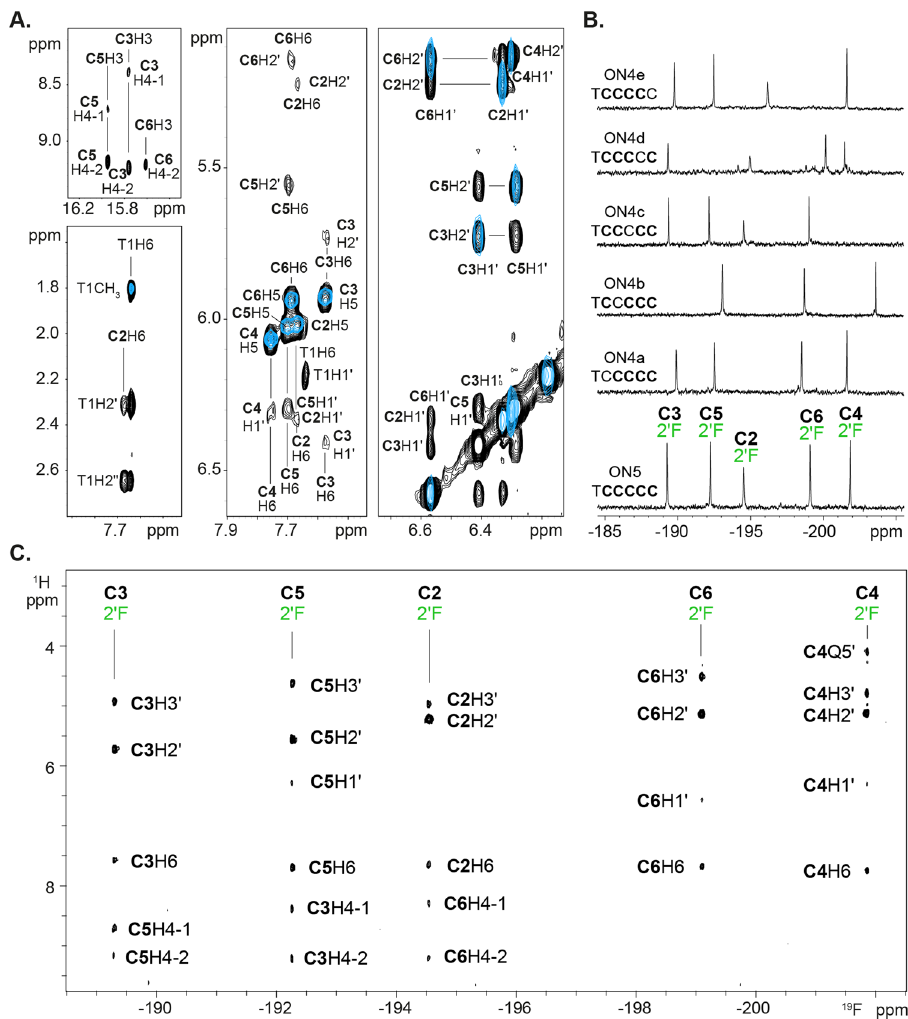
Fig. 3 Characterization of ON5 dimeric structure by NMR. A Overlapping NOESY (black) and TOCSY (blue) spectra corresponding to RA ON5. Top left: imino-amino cross-peaks. Bottom-left: cross-peaks between methyl protons of T1 and its own aromatic proton. Sequential cross-peaks between H2 ′ /H2 ′′ of T1 and H6 of C2 . Middle: fi ve intense TOCSY signals correlating H5 and H6 of the fi ve araF-C residues. Low-intensity intra-residual H1 ′ -H6 and H2 ′ -H6 cross-peaks. Right: Inter-residual H1 ′ -H1 ′ and H1 ′ -H2 ′ cross-peaks across the minor groove. B 1D 19 F NMR spectra of RA ON5 and RA ON4a-ON4e. C 1 H- 19 F HOESY spectrum of RA ON5. All spectra were acquired with 150 μ M RA ON5 in 10 mM NaP i pH 5, at 5